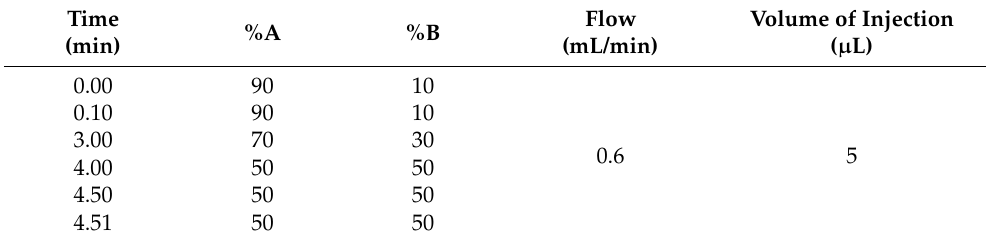
Table 1. Gradient elution of the mobile phases A (acetonitrile-water) and B (ultra-pure water) with 10 mM and 20 mM ammonium formate.